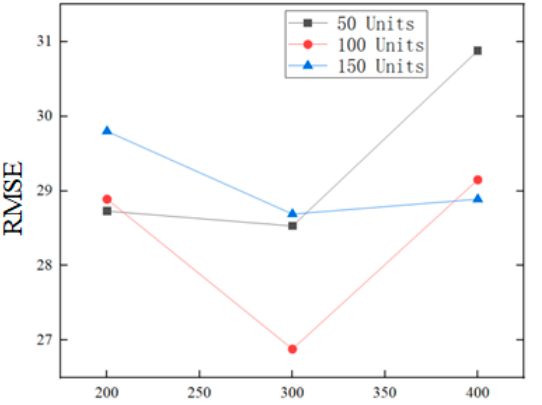
Figure 5. Influence of Unit Number and Learning Round Number on RMSE.